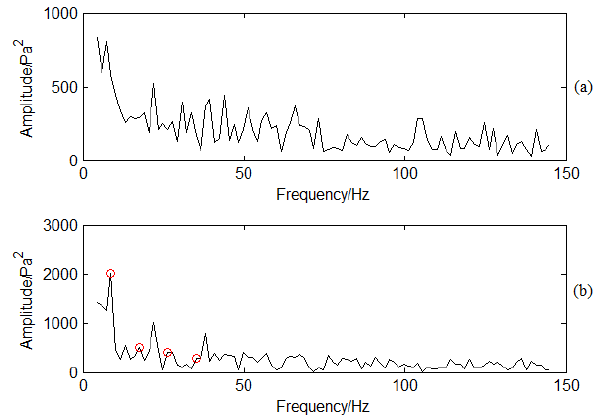
Figure 14. SES for PP signal under different working conditions: ( a ) Spectrum using SES for normal conditions; ( b ) Spectrum using SES for crack conditions.